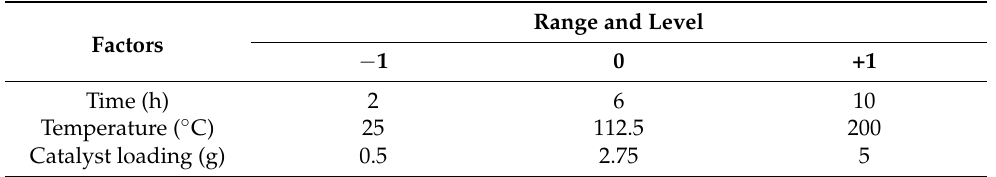
Table 1. Investigated levels for the three parameters: temperature, time, and catalyst loading using